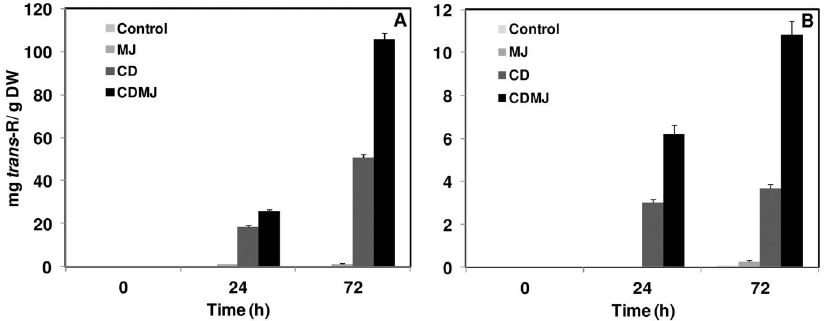
Figure 1. Effect of elicitation time course on trans -R ( trans -resveratrol) production in grapevine cells treated with CD (cyclodextrins) and/or MJ (methyl jasmonate). (A) trans -R content in the extracellular medium. (B) trans -R content in the cells. Experiments were repeated three times. Data are the mean 6 SD of the replicates.